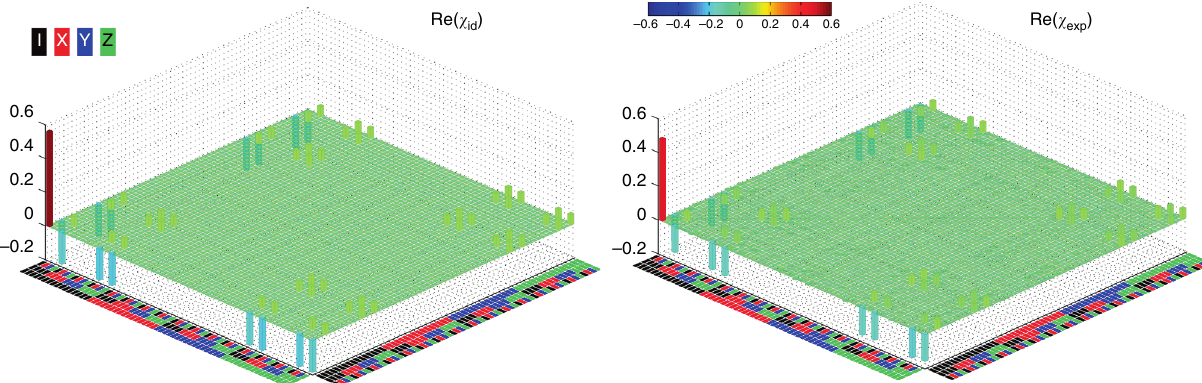
ffiffiffiffiffiffiffi p 7 : 5 MHz and detuning δ /2 π = 4 MHz. The color code for